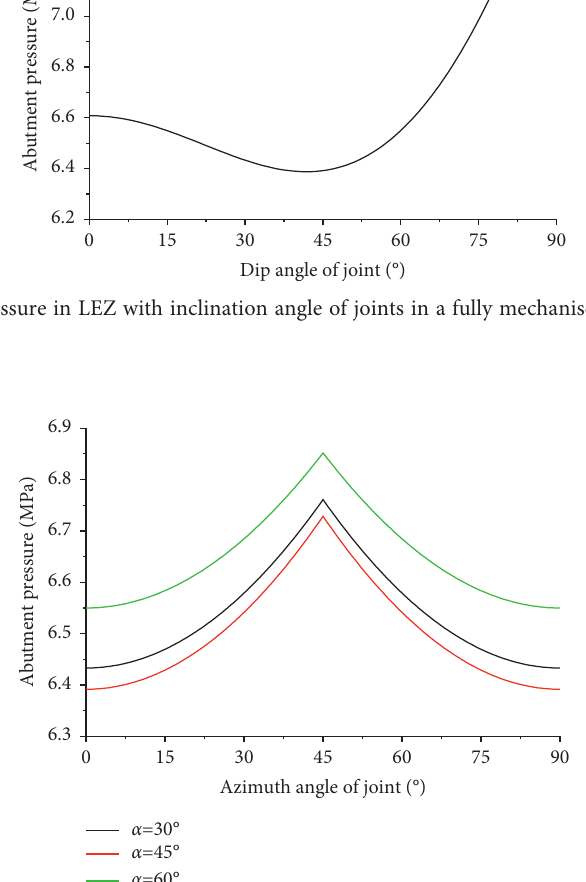
Figure 12: Change in the abutment pressure in LEZ with azimuth angle of joints in a fully mechanised working face with large mining